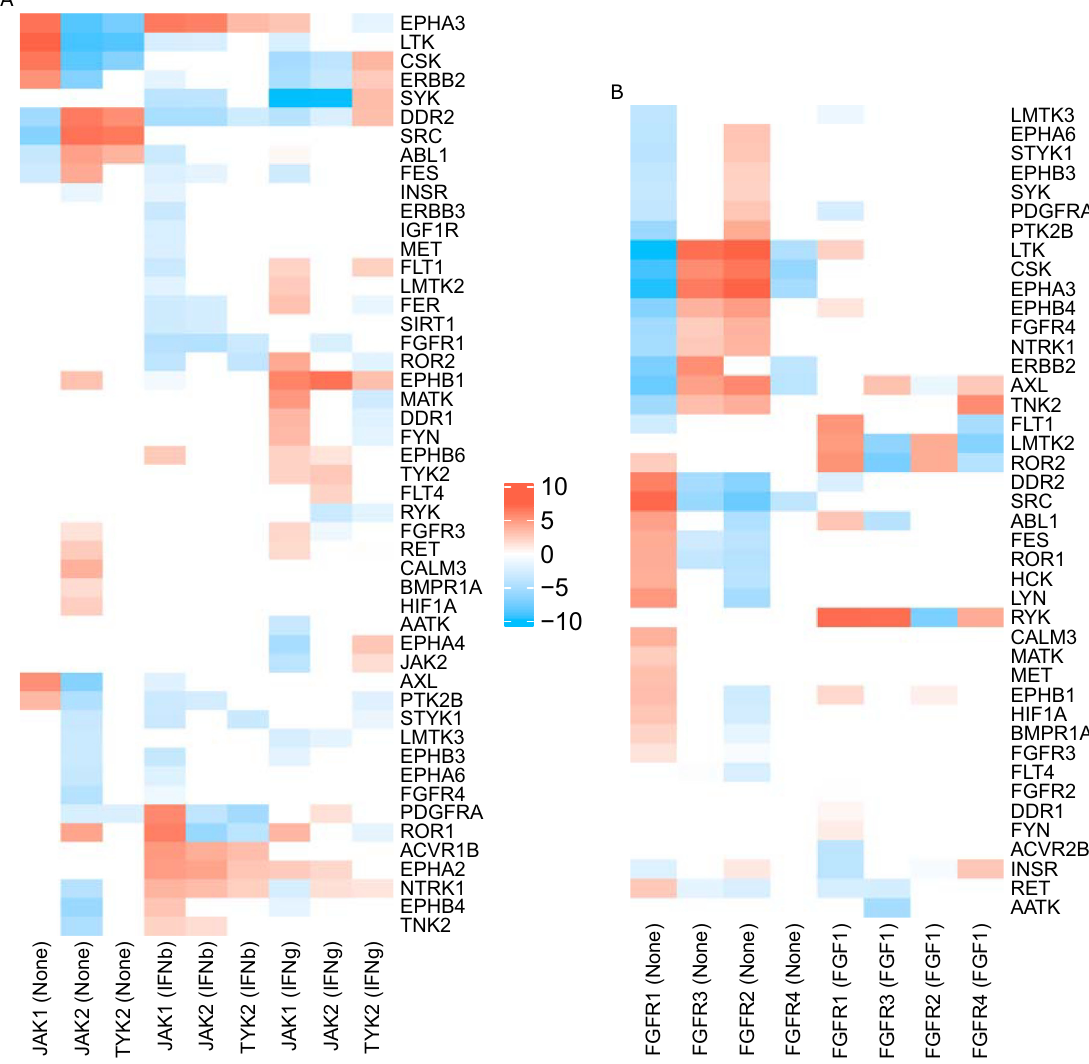
Fig 3. MRA+CLR-inferred interactions (top 20% selected). (A) Interaction strengths (in log 2 with sign preserved) between JAK1, JAK2, and TYR2 and their targets. Stimulatory conditions are in brackets (None, IFNb, IFNg). (B) Interaction strengths between FGFR1, FGFR2, FGFR3, and FGFR4 and their